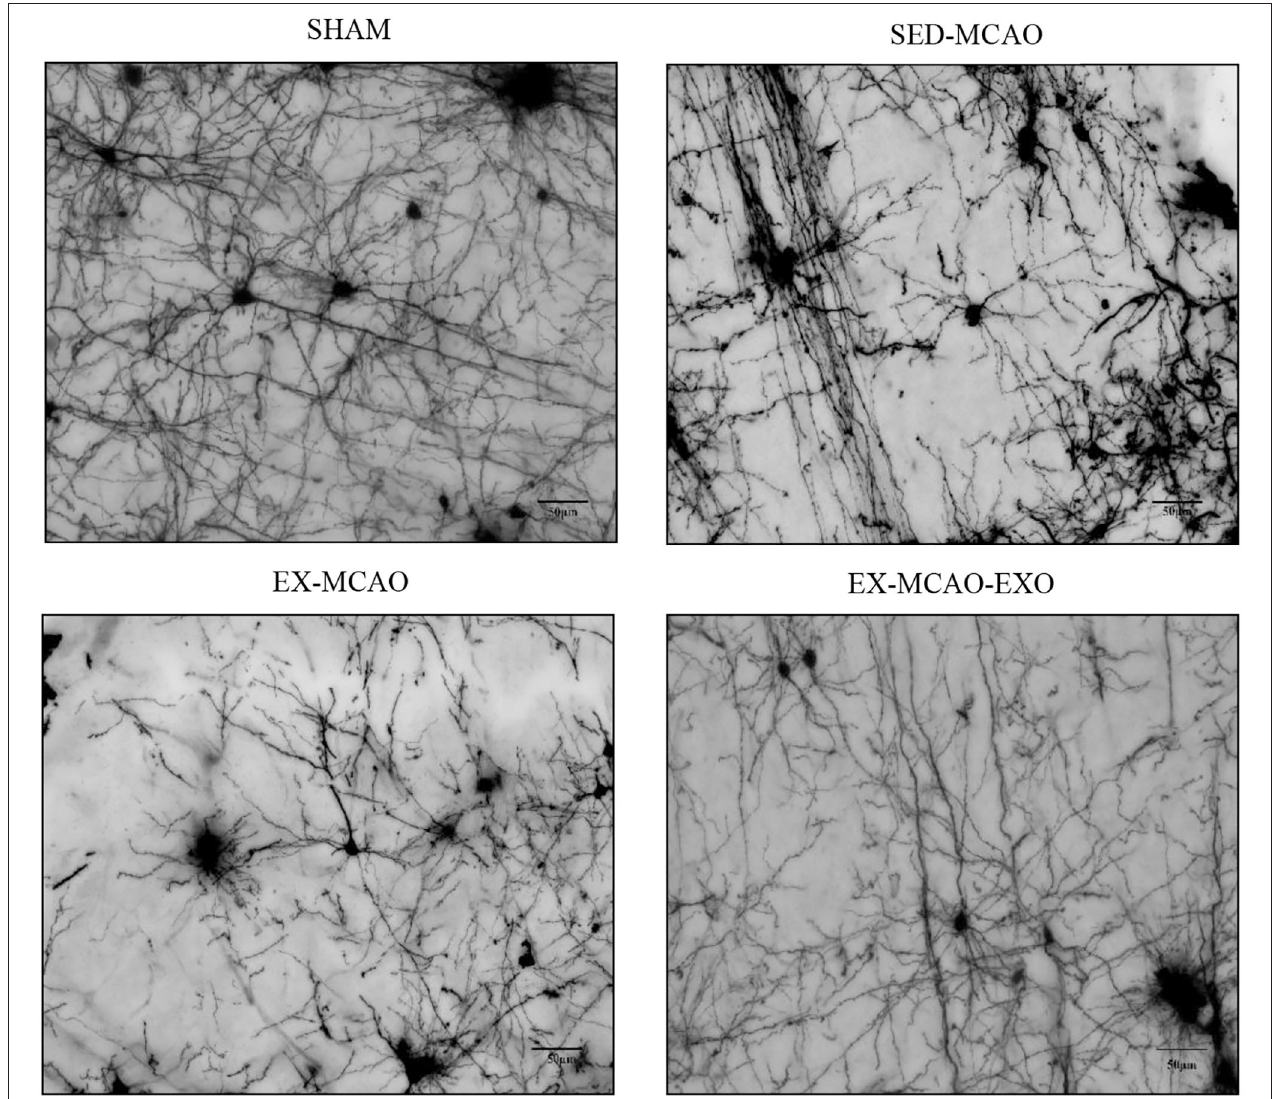
FIGURE 6 | Representative images of neuronal dendrites in the peri-infarct cortex. Bar = 50 µ m.